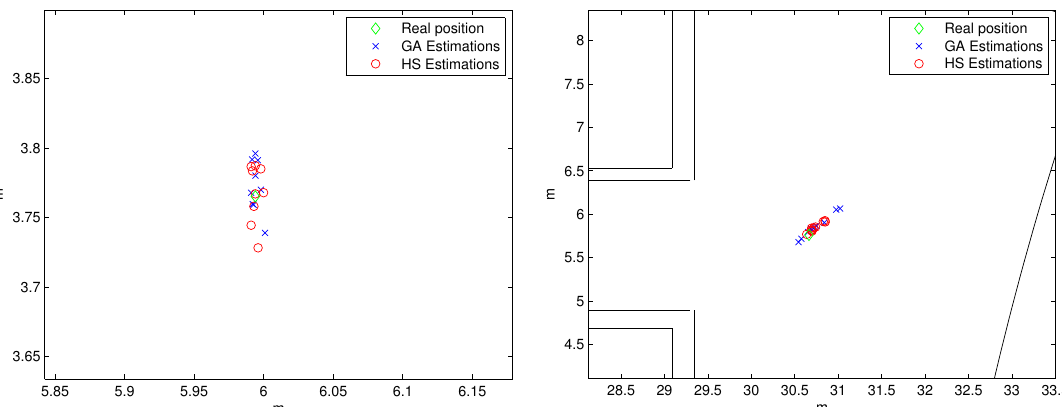
Figure 12. Experimental results for the estimations of beacon #1 (left) and beacon #2 (right). Note that the X-Y scales are completely different in these two subplots.